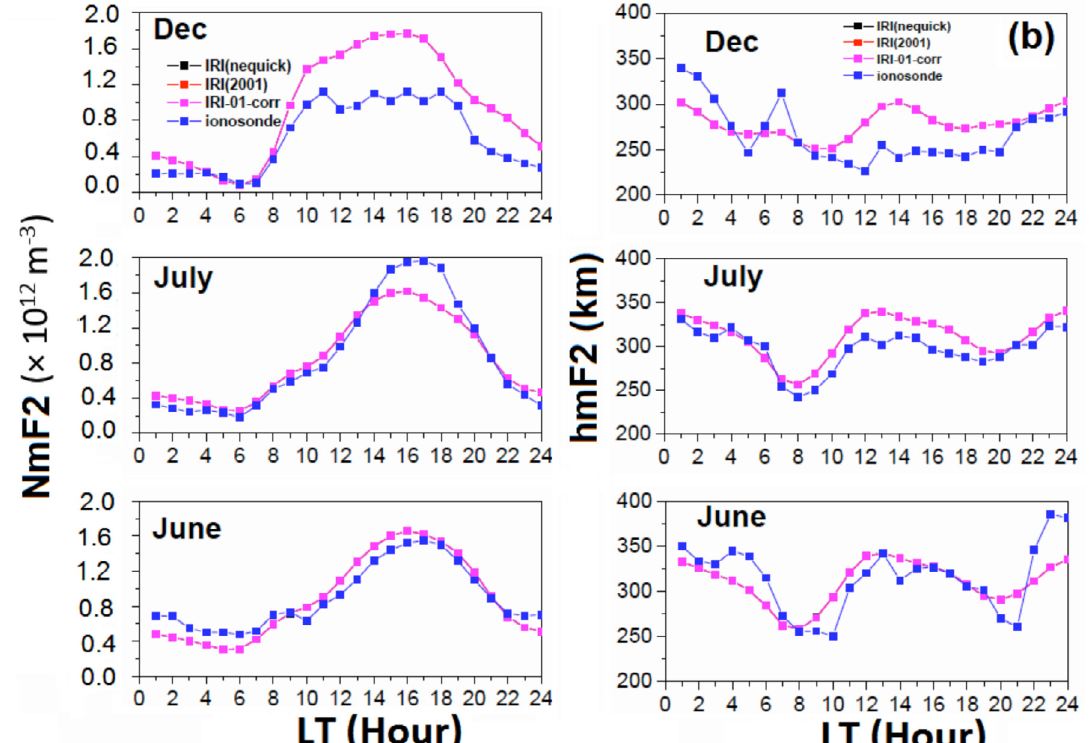
Figure 9. Comparison of IONOSONDE derived F2 peak electron density (NmF2) and height (hmF2) with IRI 2012 model during June, July and August of year 2012 over Ahmedabad,